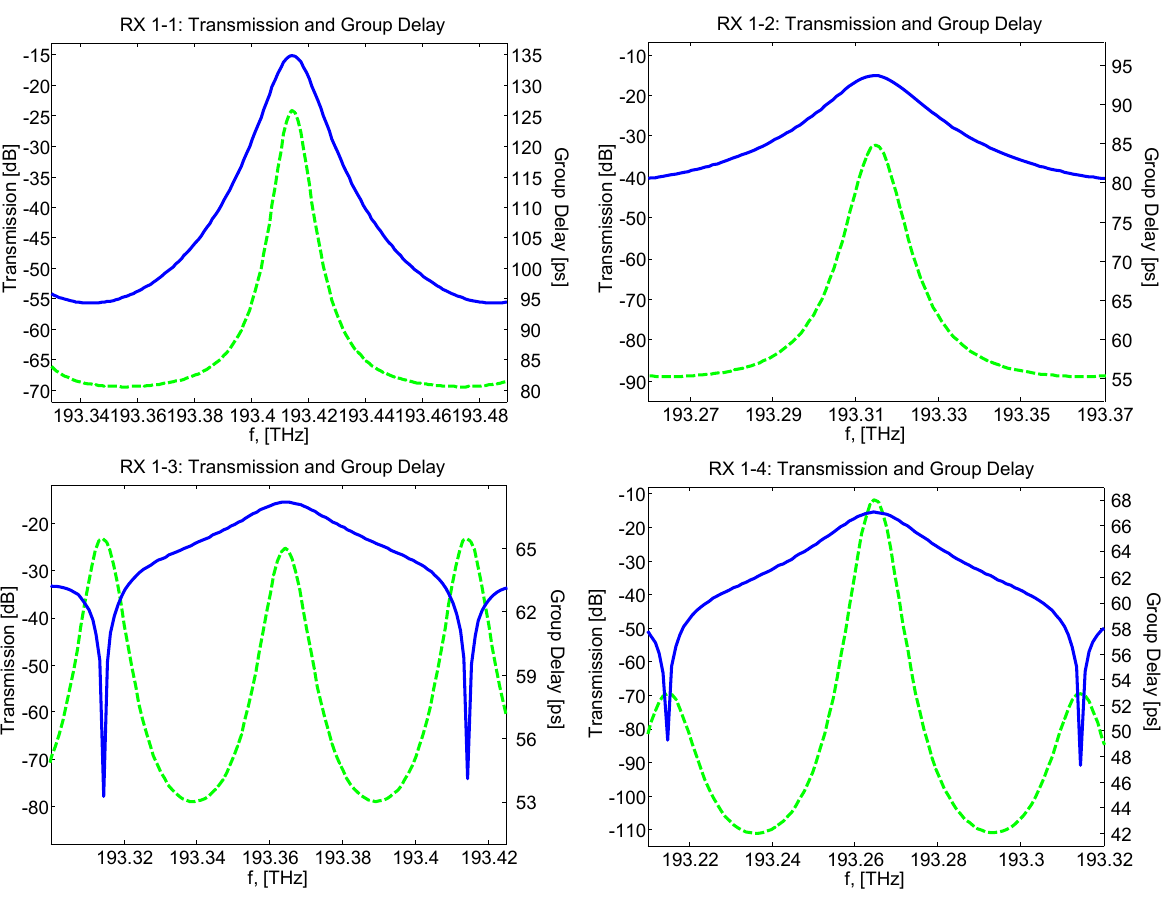
Figure 7. Transfer function “-” and group “- -” delay at RXs after the RSC at plane